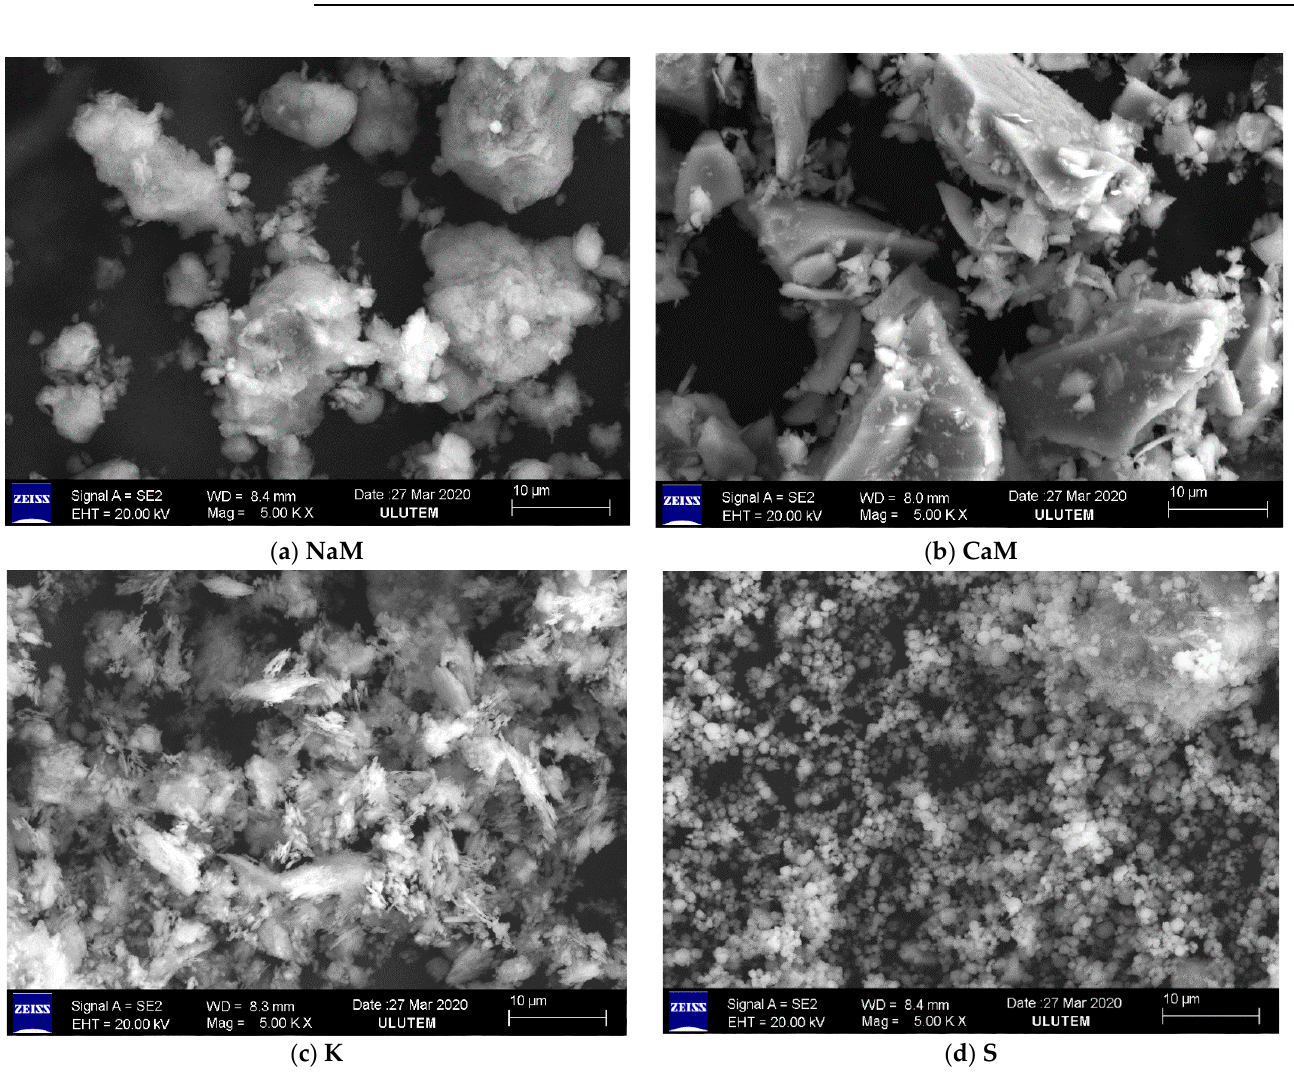
Figure 2. SEM images of ( a ) Na-Montmorillonite ( NaM ), ( b ) Ca-Montmorillonite ( CaM ), ( c ) Kaolinite ( K ) and ( d ) Sepiolite ( S ). Table 1. Results of tests by both Casagrande cup and Fall cone methods.